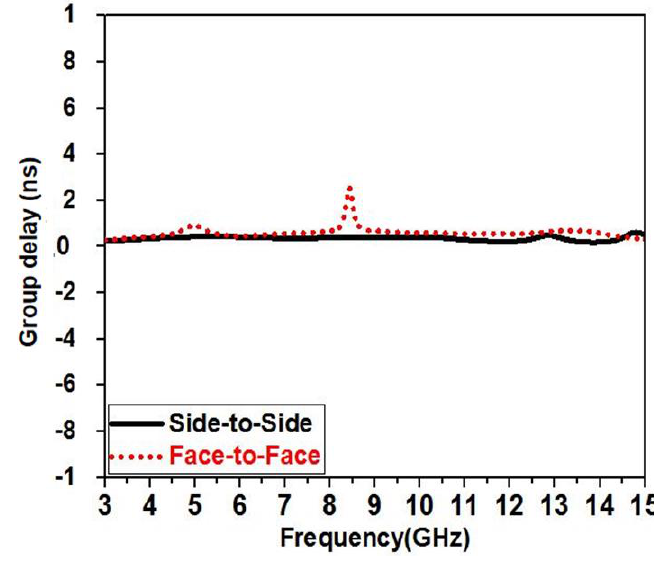
Figure 28. Analysis in time-domain with ( a ) frontal and ( b ) lateral orientations.